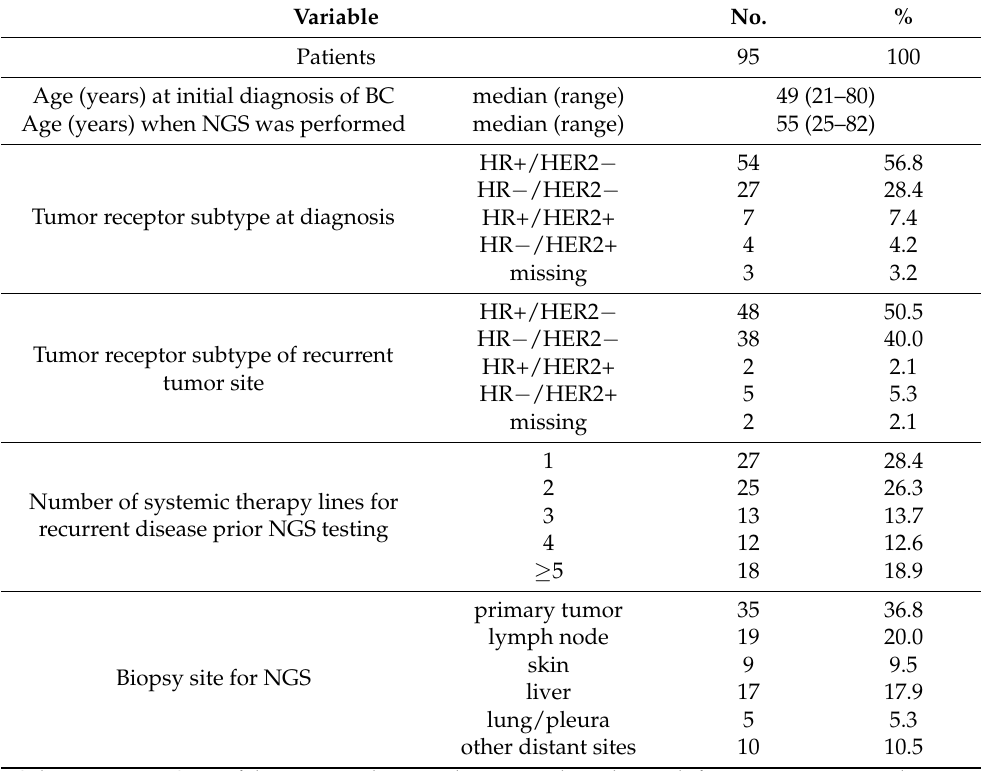
Table 1. Clinical and demographic characteristics of 95 patients with metastatic breast